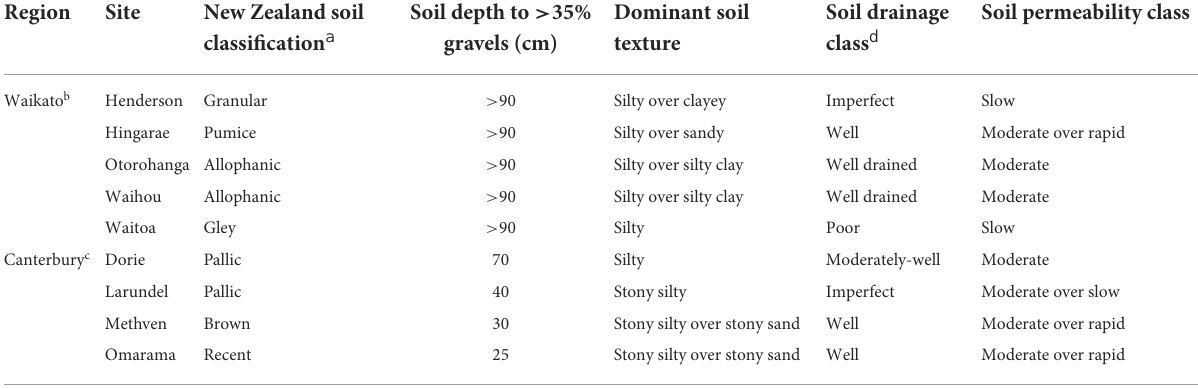
TABLE 3 Summary of soil classification and key features at each site.